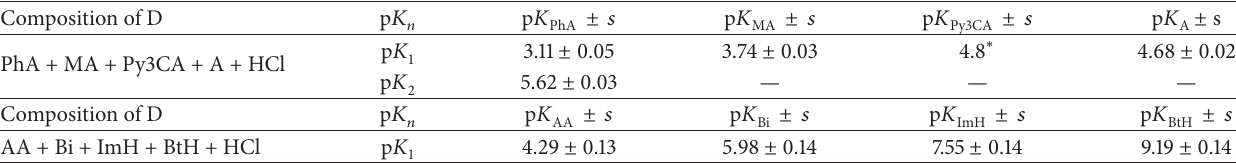
Table 6: The p 𝐾 ’s values of compounds determined in the mixture containing four-weak electrolytes (acids and bases) and a strong acid a (HCl) at 25 ∘ C.